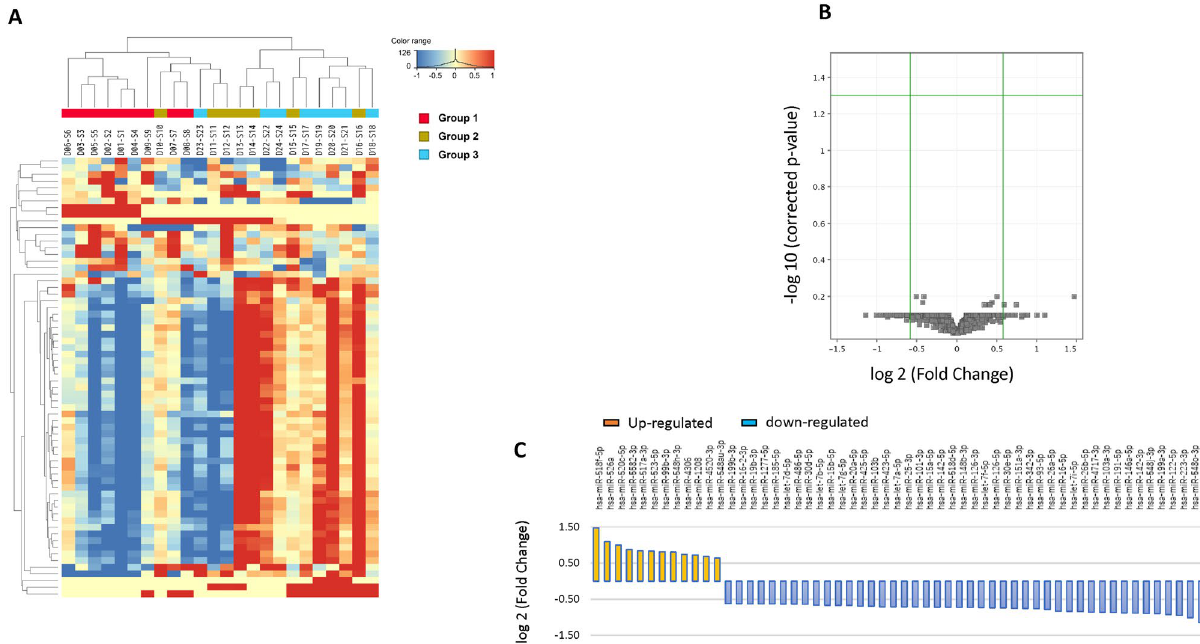
Figure 3. ( A ) Hierarchical clustering heatmap of 24 samples from patients with stage I lung adenocarcinoma. ( B ) Volcano plot of differentially expressed miRNAs between the G1 + 2 (LVI +) and G3 (LVI–) cohorts. ( C ) Charts indicate the fold-change expression of 66 miRNAs obtained as LVI marker